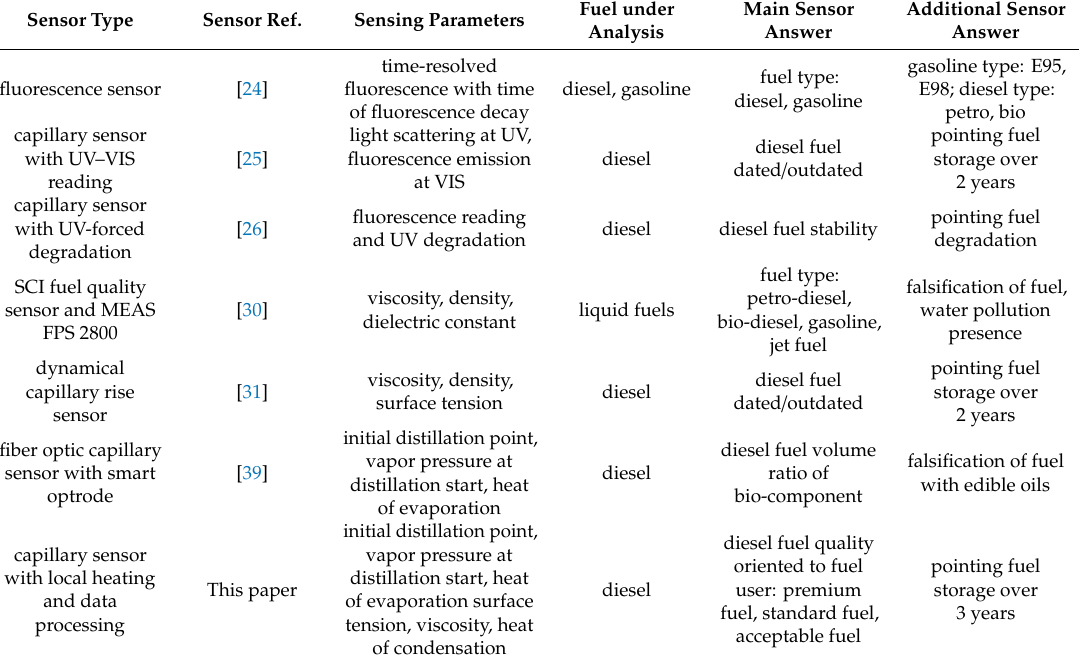
Table 3. Comparisons of sensors oriented to diesel fuel examination accessible in literature and described in this